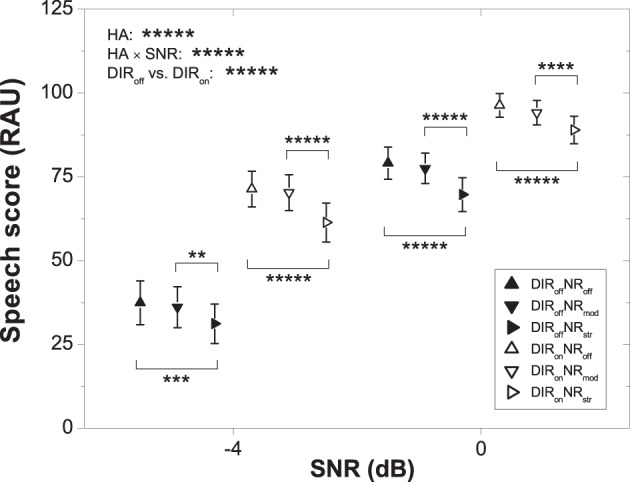
Mean speech scores for the six HA conditions and two SNRs. Error bars show 95% confidence intervals. Horizontal bars denote significant differences (**p < 0.01, ***p < 0.001, ****p < 0.0001, *****p < 0.00001). HA denotes HA condition.